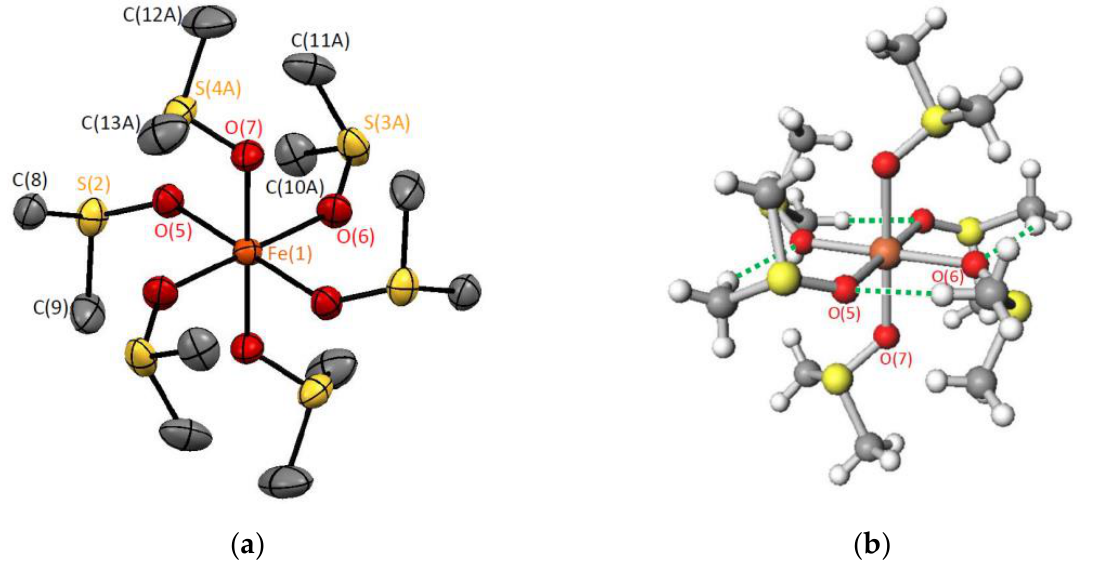
Figure 1. Crystal structures of [Fe(dmso) 6 ] 2+ at 203 K: ( a ) With atom labelling and ( b ) with hydrogen-bonds marked as green dot line. Disordered minor structures are omitted for clarity.